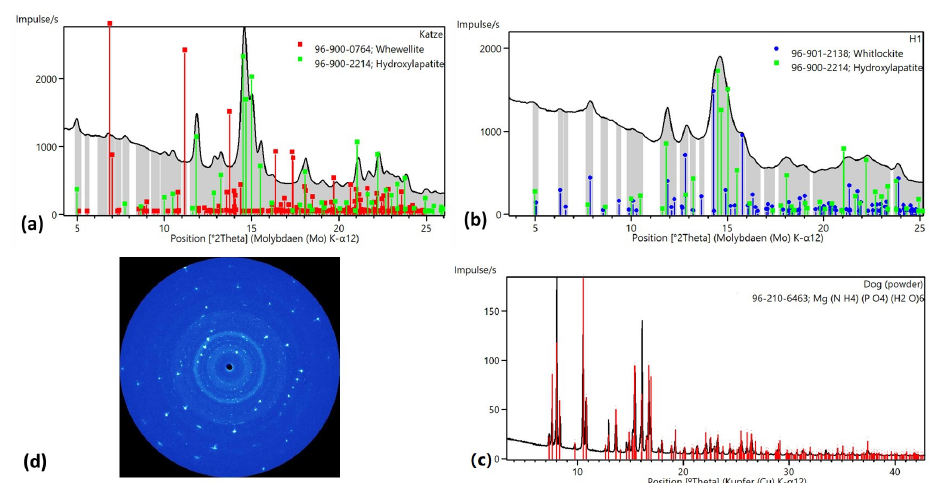
Figure A1. Detailed phase analysis of three urinary stones. XRD 1D profiles of stones from ( a ) a cat, ( b ) a human, and ( c ) a dog. ( d ) A 2D diffraction image with the high-intensity dots showing the single